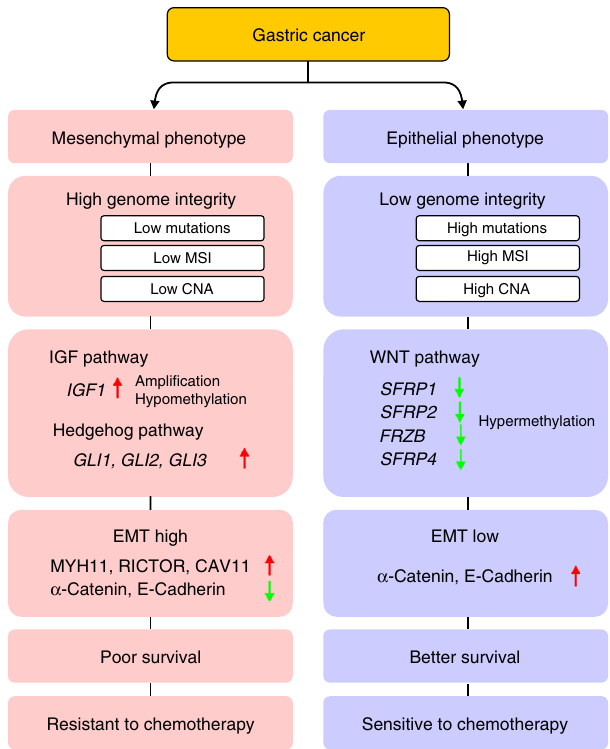
Fig. 9 Summary of characteristics of the two subtypes of gastric cancer. CNA copy number alteration, EMT epithelial-to-mesenchymal